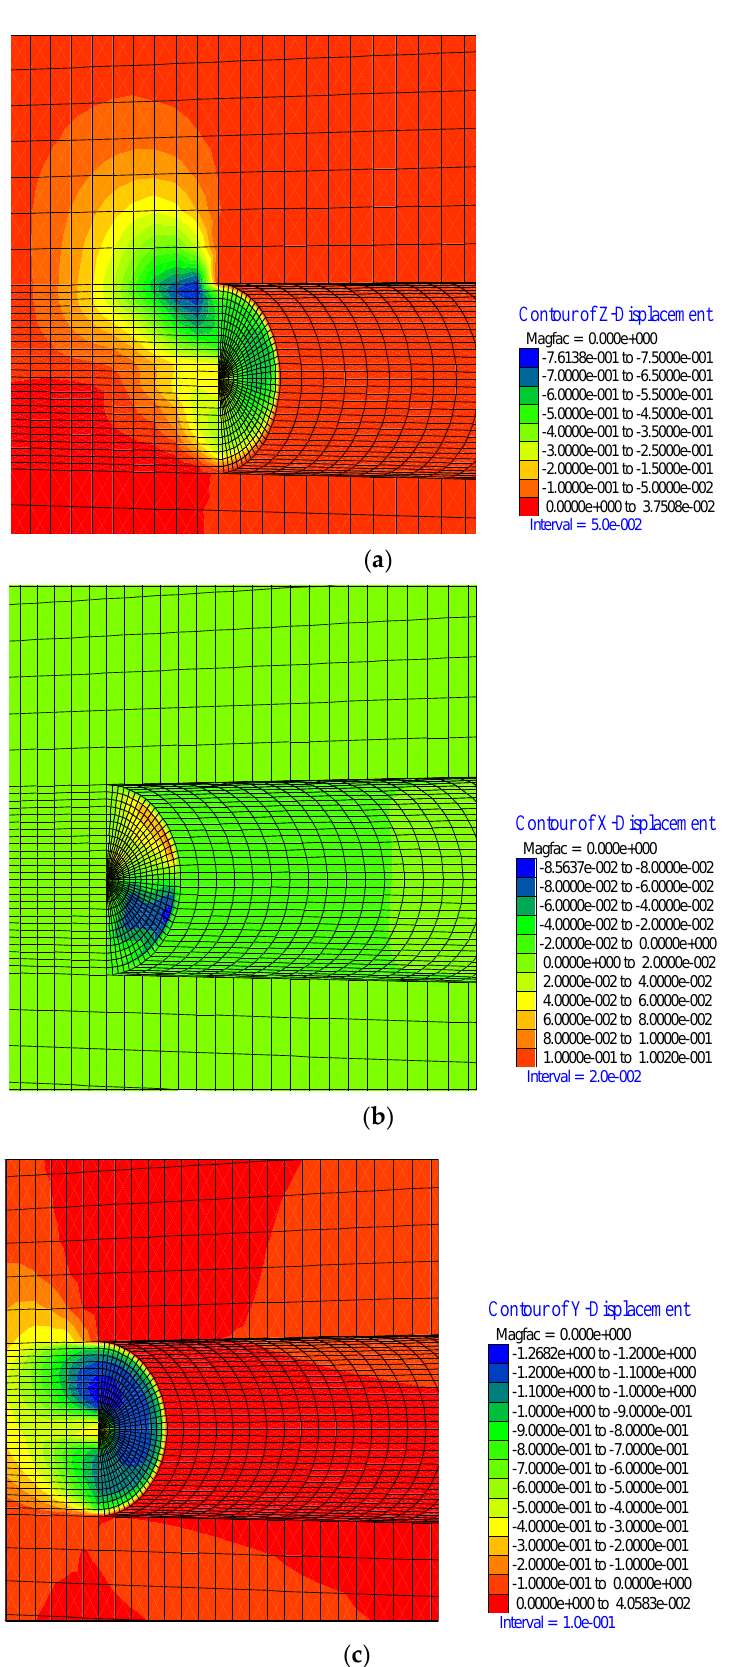
Figure 12. Deformation results in third stage ( a ) Vertical displacement, ( b ) Horizontal displacement, ( c ) Face displacement. (units in m).